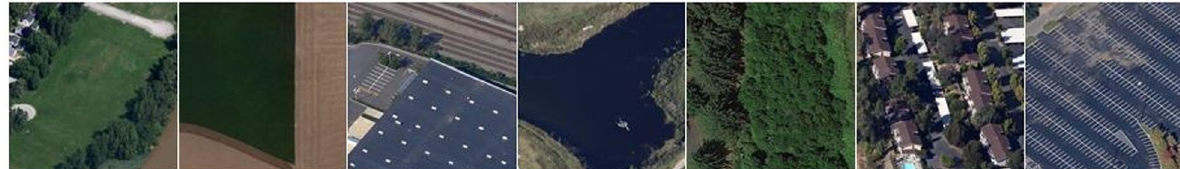
Fig 6. A photo gallery of images from RSSCN image